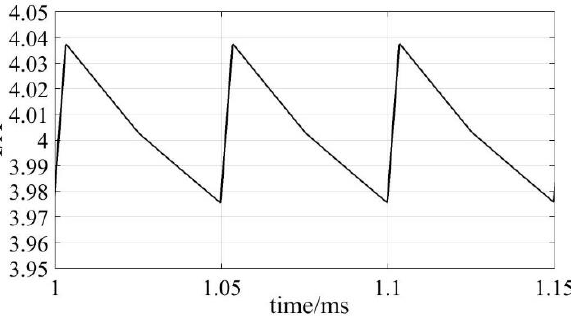
Figure 15. Current ripple of the SPA with a neutralized-sharing-bridge topology.